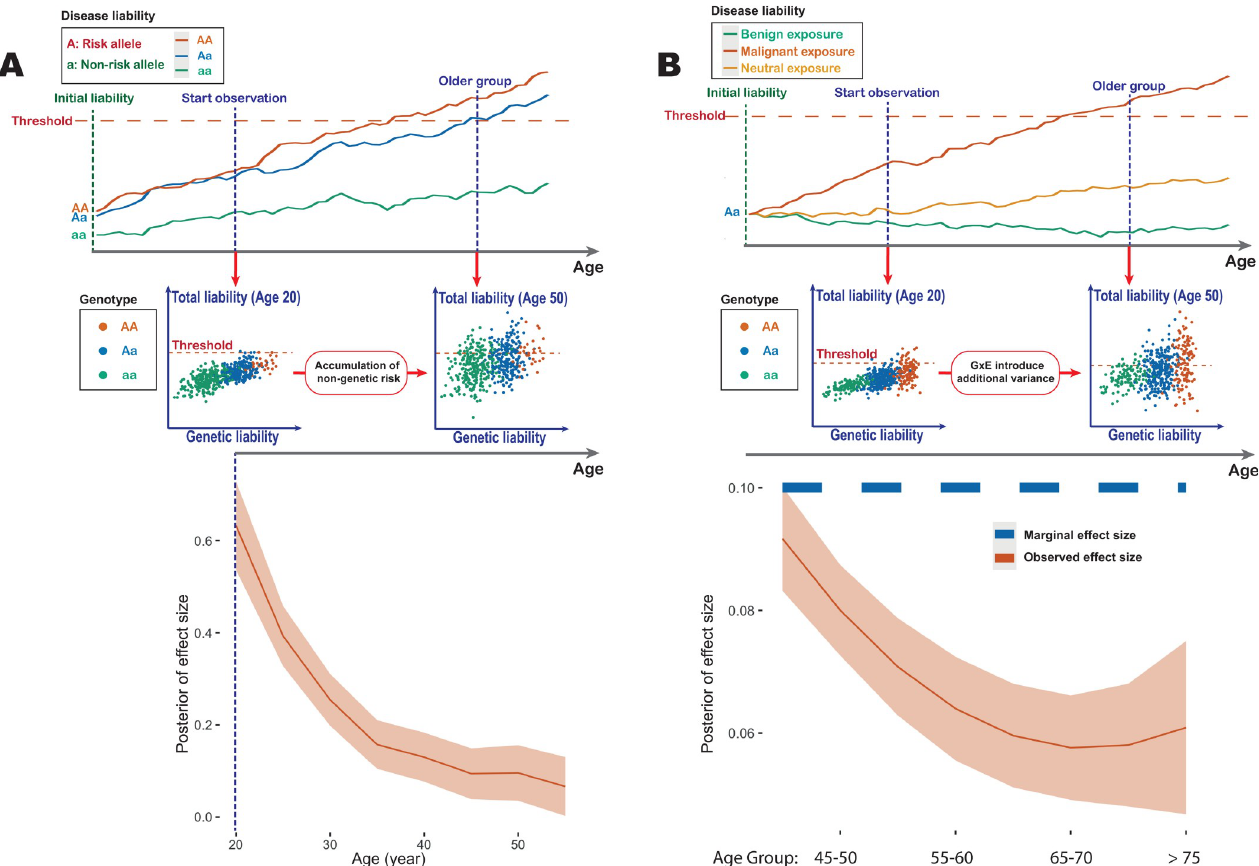
Fig 6. Models for a decreasing influence of genetic risk with age. (A) A threshold model, in which each individual has a disease “liability” which evolves over age. Disease onset occurs when liability crosses a threshold. The upper panel shows example trajectories, where genetic risk alters only the liability baseline. The middle panel is a schematic representation of a simulation in which genetic risk affects developmental pathways at birth, while non-genetic risk accumulates over time. The lower panel shows an estimation of the effect size from a simulated dataset of UK Biobank sample size (see S1 Supplemental Methods). (B) Interactions between genetic and environmental risk factors can create a distribution of effect sizes for a specific genotype. The upper panel shows example trajectories, where the environment influences the slope of the trajectory. The middle panel shows illustrative examples of the liability distributions among individuals at different ages. Those individuals at highest risk (with both the risk allele and risk environment) enter disease earlier, diluting the apparent effect size at a later age. The lower panel shows simulation results under such a model using realistic parameters from UK Biobank (see S1 Supplemental